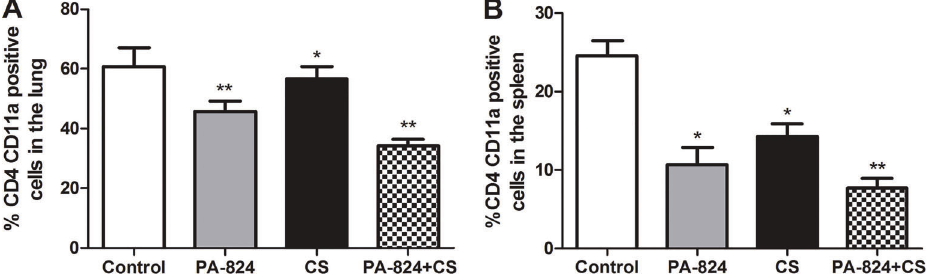
Figure 2. Expression of CD11a on CD4 + Tcells isolated from the lung and spleen after treatment with PA-824, CS or the combination of both. Lung cells ( A ) and spleen cells ( B ) were isolated from Mycobacterium tuberculosis -infected mice throughout the course of the treatment and labeled with fl uorescent antibodies speci fi c for CD4 and CD11a. Data are reported as means ± SD percentage of CD4 positive cells that expressed a high level of CD11a on their surface. CS: Cordyceps sinensis (Berk.) Sacc. *P o 0.05, **P o 0.01, compared to control (ANOVA).